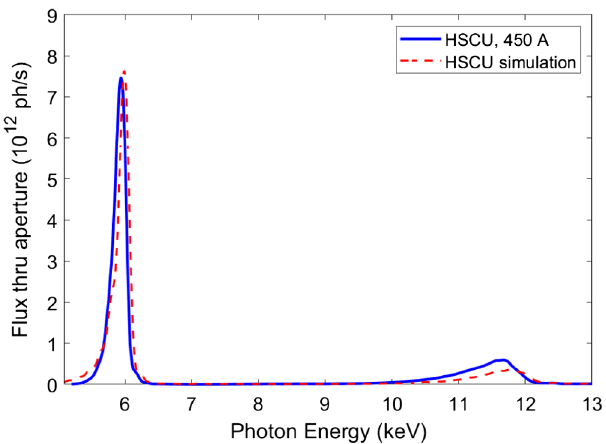
(1992).FIG. 37. Simulated and measured spectrum of HSCU with the device operating with a 450 A current. The aperture is 0.2 mm vertical by 0.6 mm horizontal at 27 m from the source, giving an angular aperture of 7 . 5 μ rad vertical by 22 μ rad